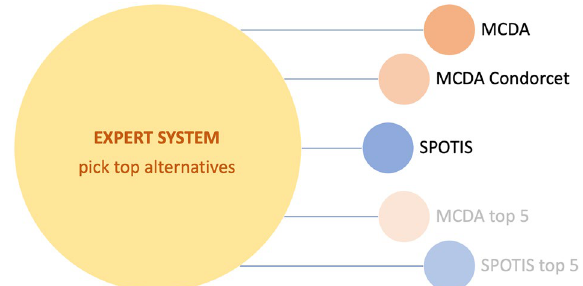
Figure 6. Expert System to identify the top alternatives.